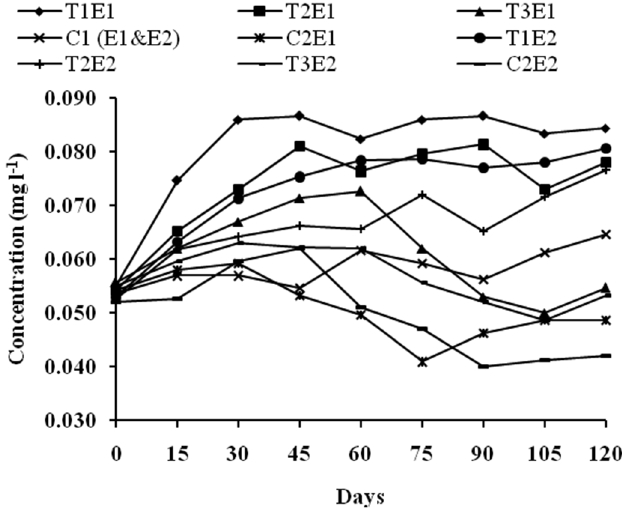
Fig. 6. Temporal changes in ortho-P ofwaterin all the treatments of E1 and